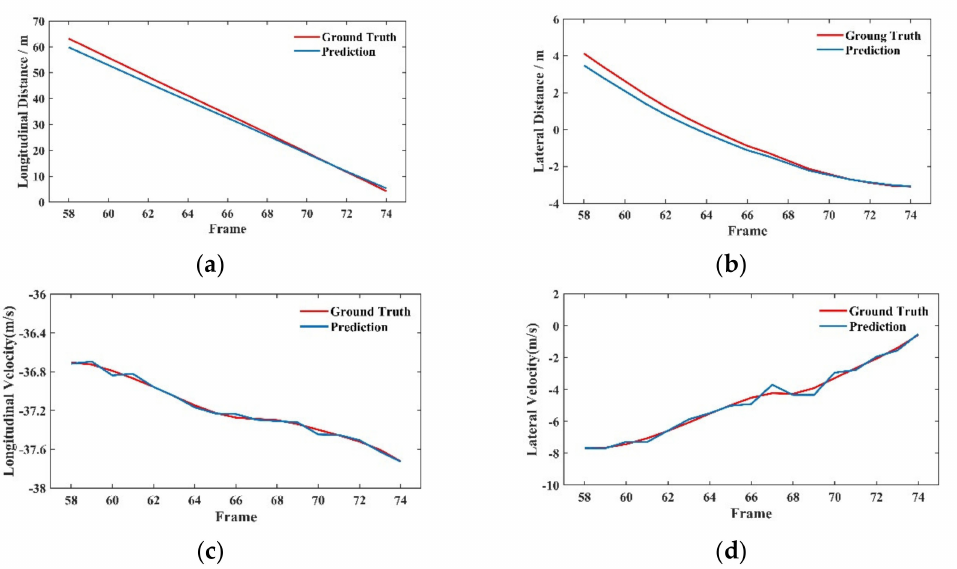
Figure 11. Real–time variation curve of the distance and speed of the target vehicle in the opposite direction of incoming traffic scenario. The red lines represent the true values, ( a – d ) are the longitudinal transverse distance and longitudinal transverse velocity.